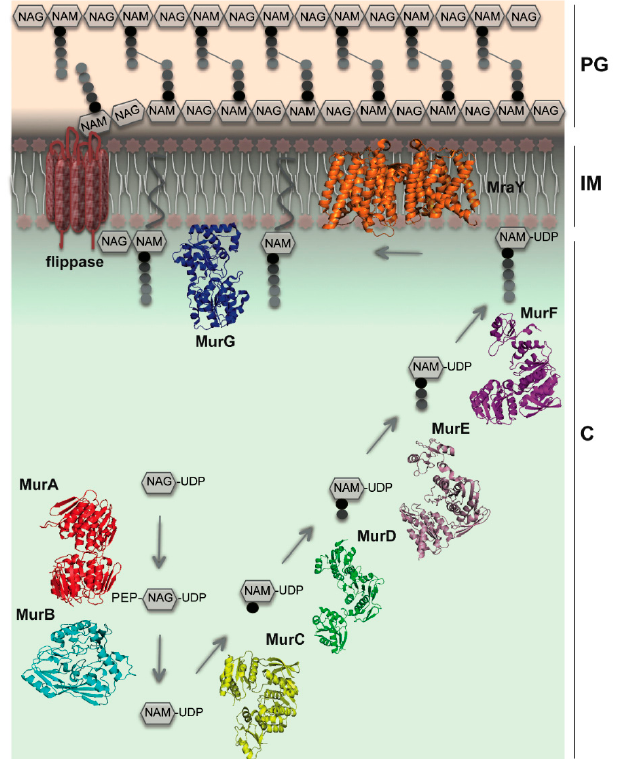
Figure 1. A simplified view of cytoplasmic and membrane-related steps of PG biosynthesis. The concerted action of MurA and MurB generates the initial precursor, UDP-N-acetyl muramic acid (UDP-NAM). Mur ligases (C–F) catalyze the stepwise addition of a pentapeptide to UDP-N-acetyl muramic acid (UDP-NAM). MraY anchors the UDP-NAM-pentapeptide unit to the inner membrane through an undecaprenyl phosphate carrier lipid, forming lipid I. MurG participates in the formation of the final peptidoglycan building block (Lipid II), which is then flipped to the periplasm by flippases. C: cytoplasm; IM: inner membrane; PG: peptidoglycan layer. Cytoskeletal elements are not shown for simplicity. PDB codes of molecules depicted here: MurA (1NAW); MurB (1MBT); MurC (1J6U); MurD (4BUC); MurE (4BUB); MurF (3ZL8); MurG (1F0K); MraY